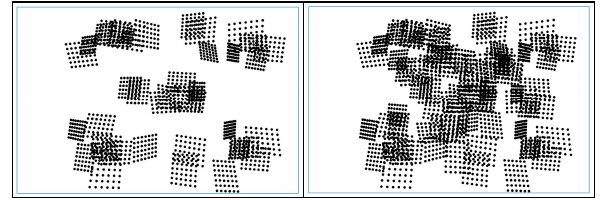
Figure 10. Overall point distribution over the whole image format (of 8 images) in the cases of 5 and 9 chessboards.